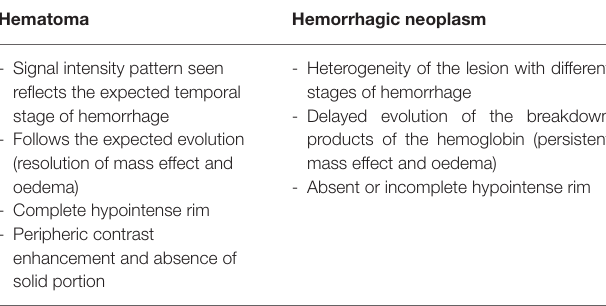
TABLE 2 | The MRI characteristics of intracranial intra-axial hematomas compared to those of intracranial intra-axial hemorrhagic neoplasia as reported in humans. Hematoma Hemorrhagic